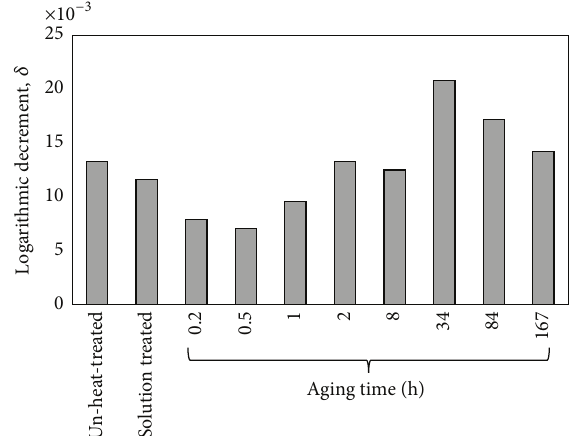
Figure 7: The logarithmic decrement of un-heat-treated, solution treated, and aged AZ61 alloy.